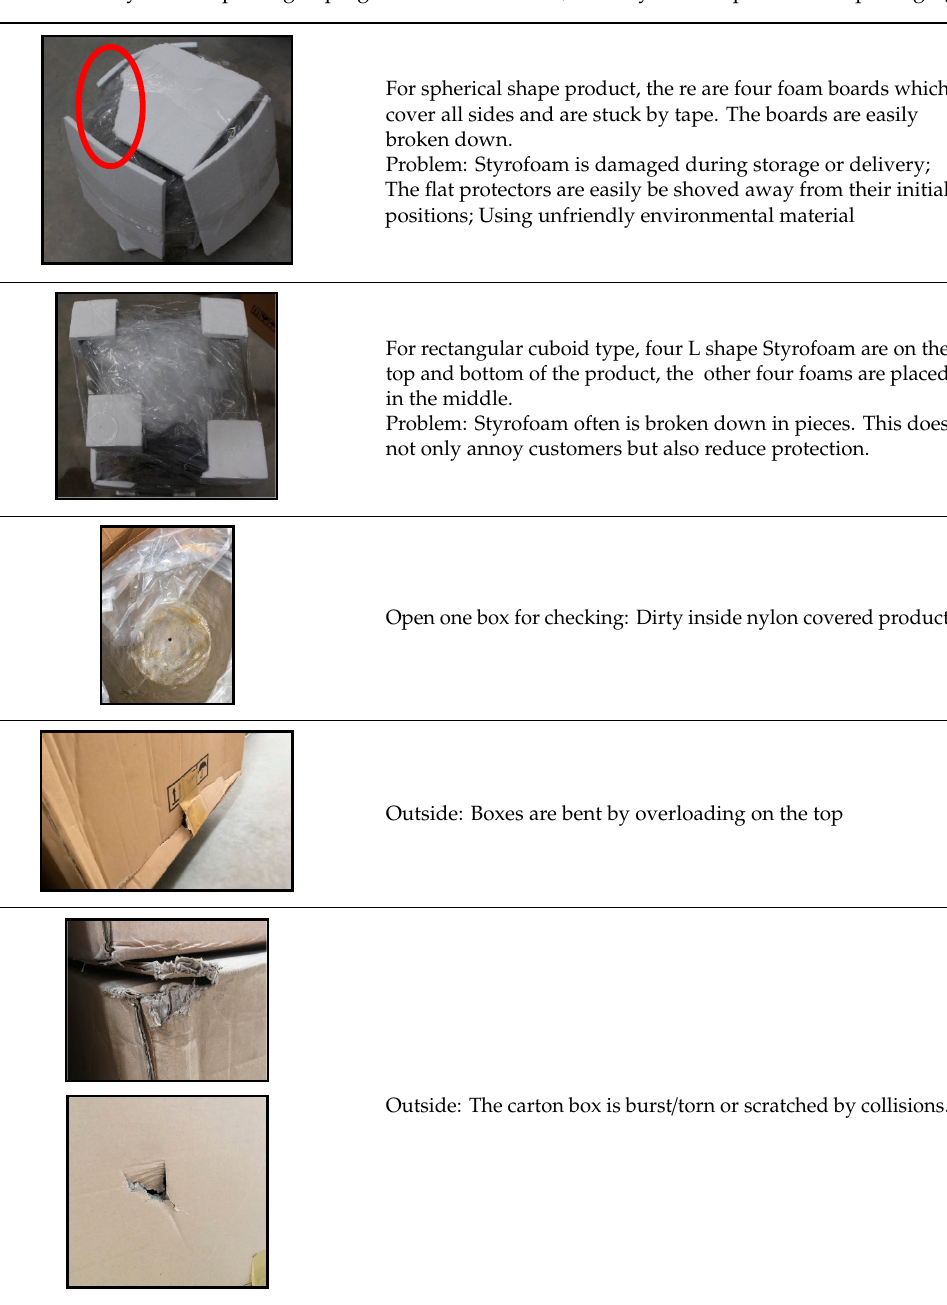
Table 2. An analysis example of grasping the actual situation, identify current problems in packaging.